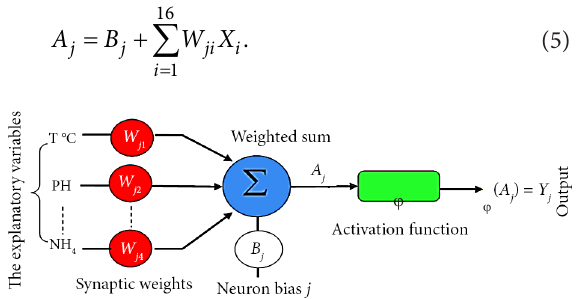
Figure 3. Structure of a formal neuron